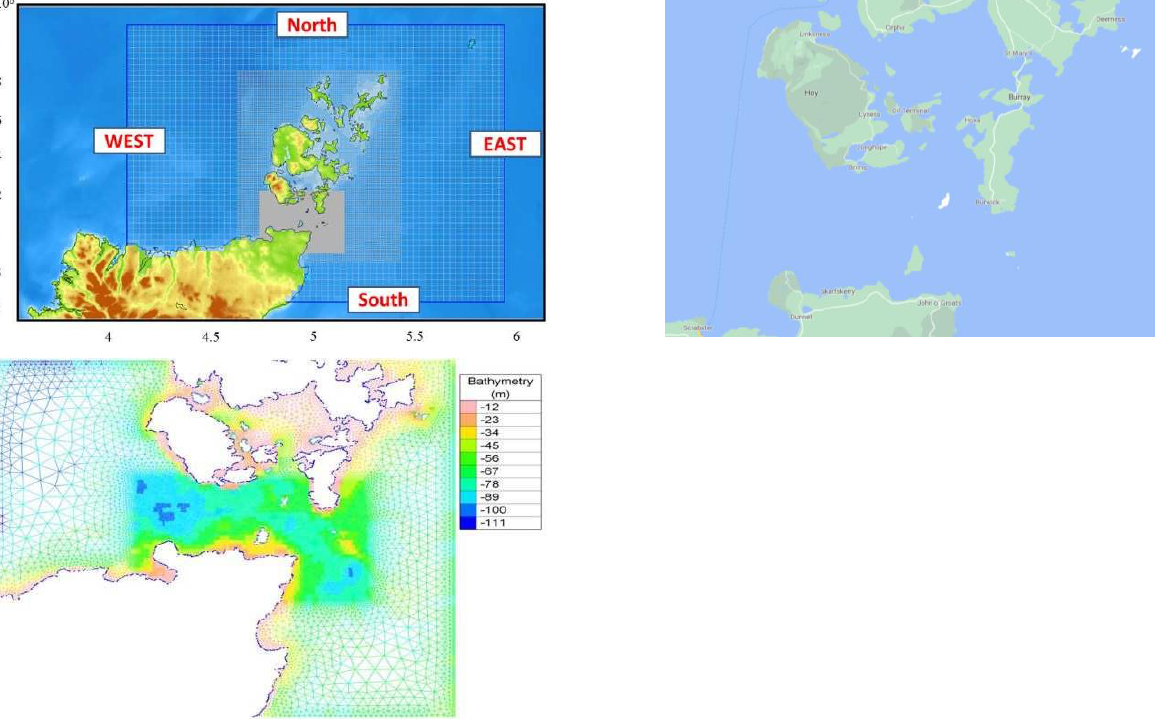
Figure 13. Pentland Firth and Orkney Waters in the United Kingdom—domain, bathymetry and ADPC measurements devices locations [40].